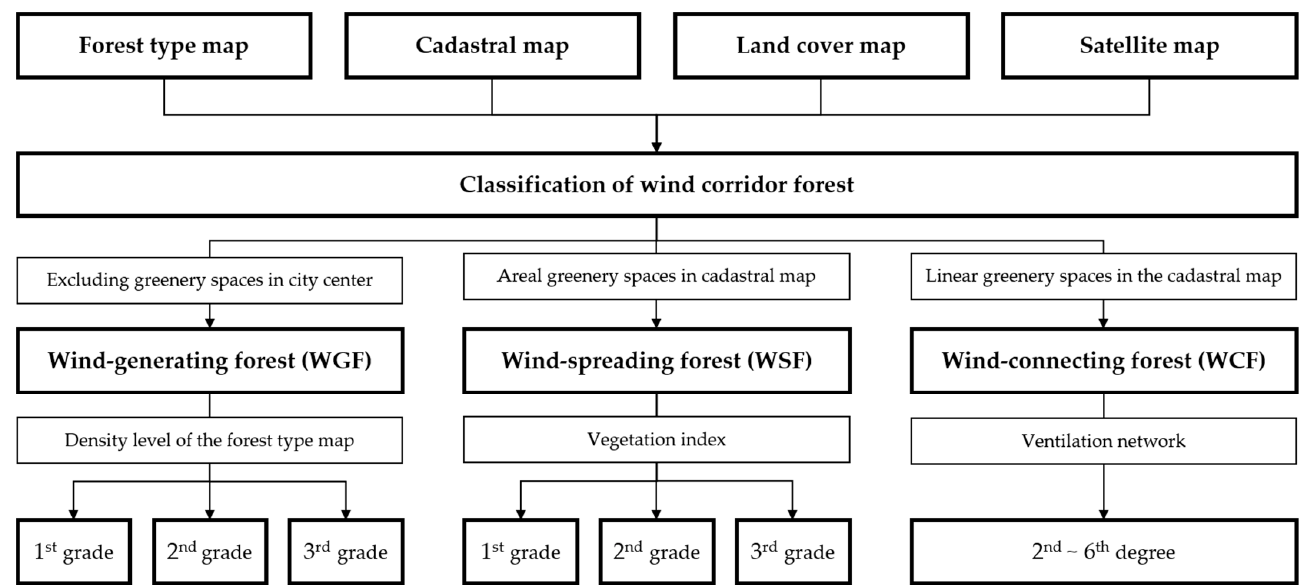
Figure 3. Analysis schemes for wind corridor forests in this study .